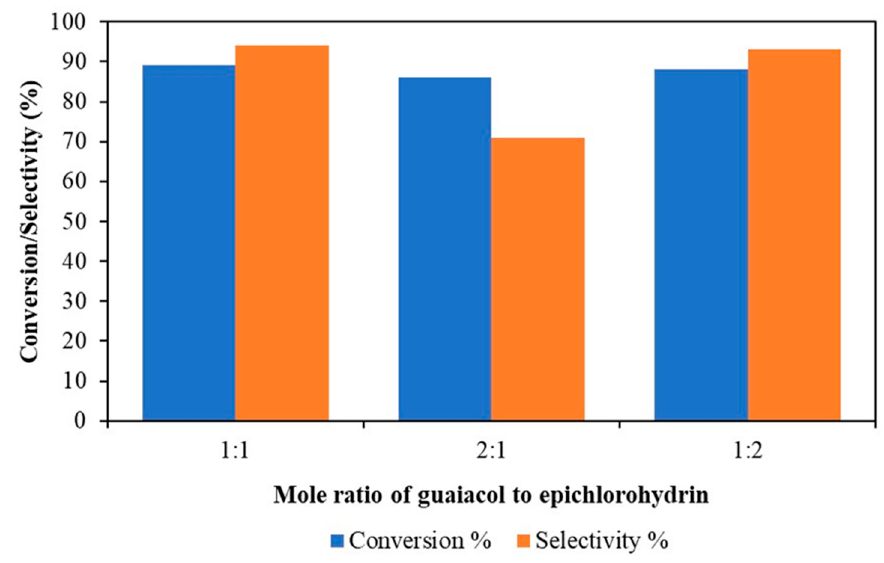
Figure 5. Effect of the mole ratio of guaiacol to epichlorohydrin. N-decane 0.03 mol, toluene 150 cm 3 , sodium chloride 0.6 mol, tetra-n-butylammonium bromide 0.14 mol, and water 150 cm 3 . Temperature 40 °C, speed of agitation 60 rpm for all three phases, and reaction time 6 h.